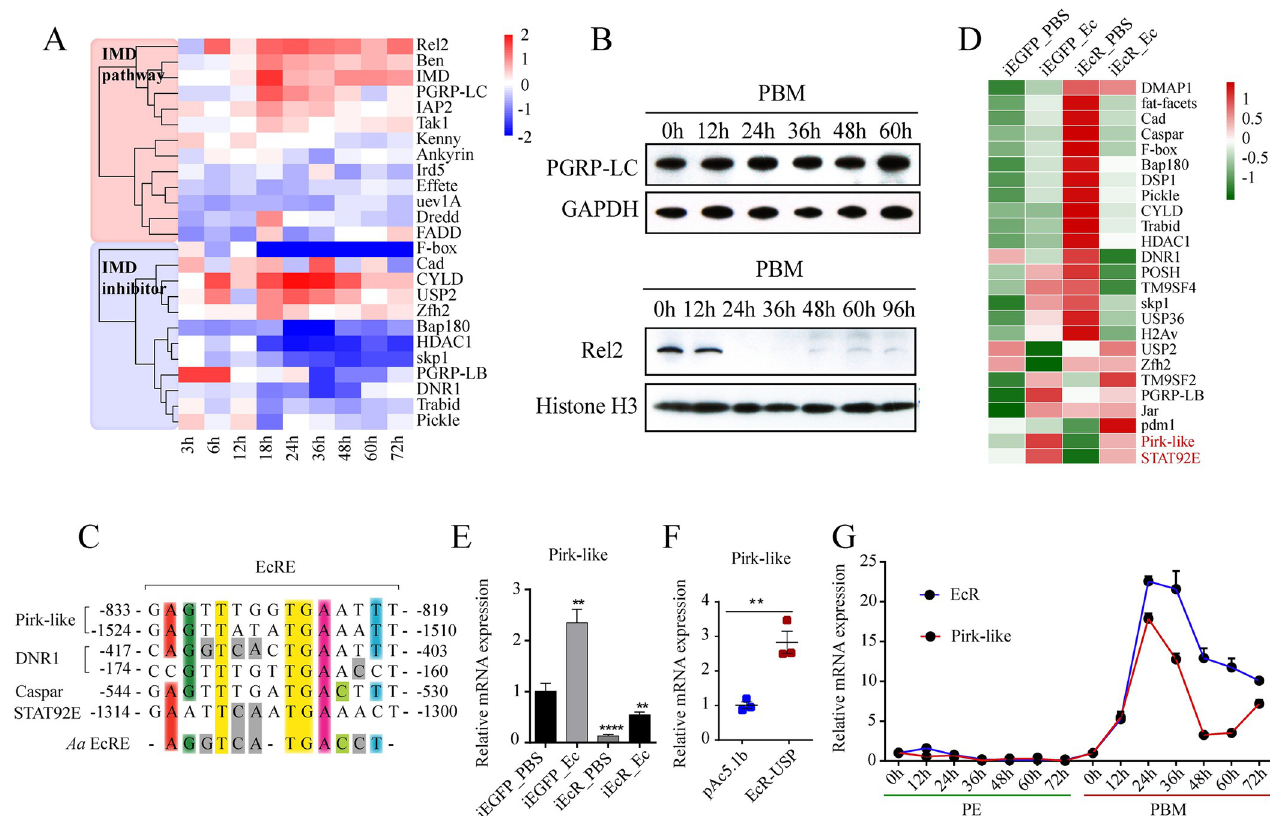
Fig 3. Pirk-like expression is regulated by 20E signaling. (A) Heat map of transcriptional patterns of the IMD pathway component genes during PBM phases. Gene expression at each time point was normalized to PE 72 h. (B) Protein levels of PGRP-LC and Rel2 determined using western blots. For each time point, both cytoplasmic and nuclear protein extracts were prepared from ten female mosquito fat bodies. GAPDH and Histone H3 were used as controls. (C) Putative EcRE of the IMD pathway inhibitors aligned with reported Aedes EcRE sequences. The three core amino acids are highlighted with yellow. (D) Heatmap showing the expression pattern of 25 IMD inhibitor genes in iEcR mosquitoes compared with iEGFP mosquitoes upon E . cloacae infection. (E) mRNA abundance of Pirk-like in iEcR mosquitoes infected by E . cloacae . Bar plots are shown as mean ± SEM. ���� p < 0.0001 (one-way ANOVA followed by Bartlett’s test). Data are from three biological replicates. (F) mRNA abundance of Pirk-like in Aag2 cells co-transfected EcR and USP. (G) Expression of Pirk-like and EcR in the PE and PBM phases. Dot plots represent mean ± SEM. Data are from three biological replicates.